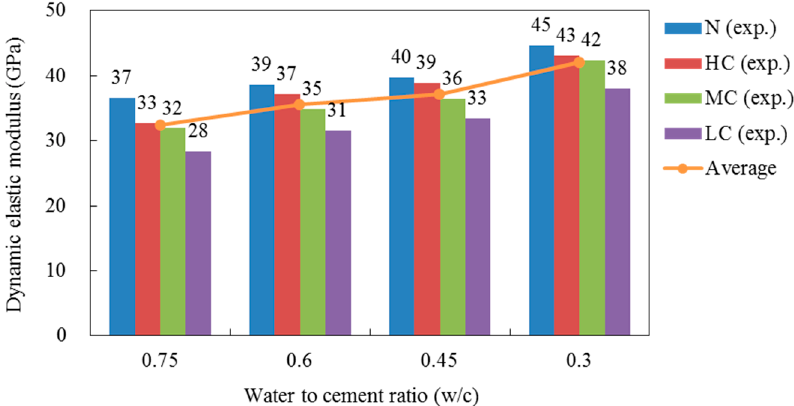
Figure 11. Dynamic modulus of concrete at 28 days with different water-to-cement ratios.